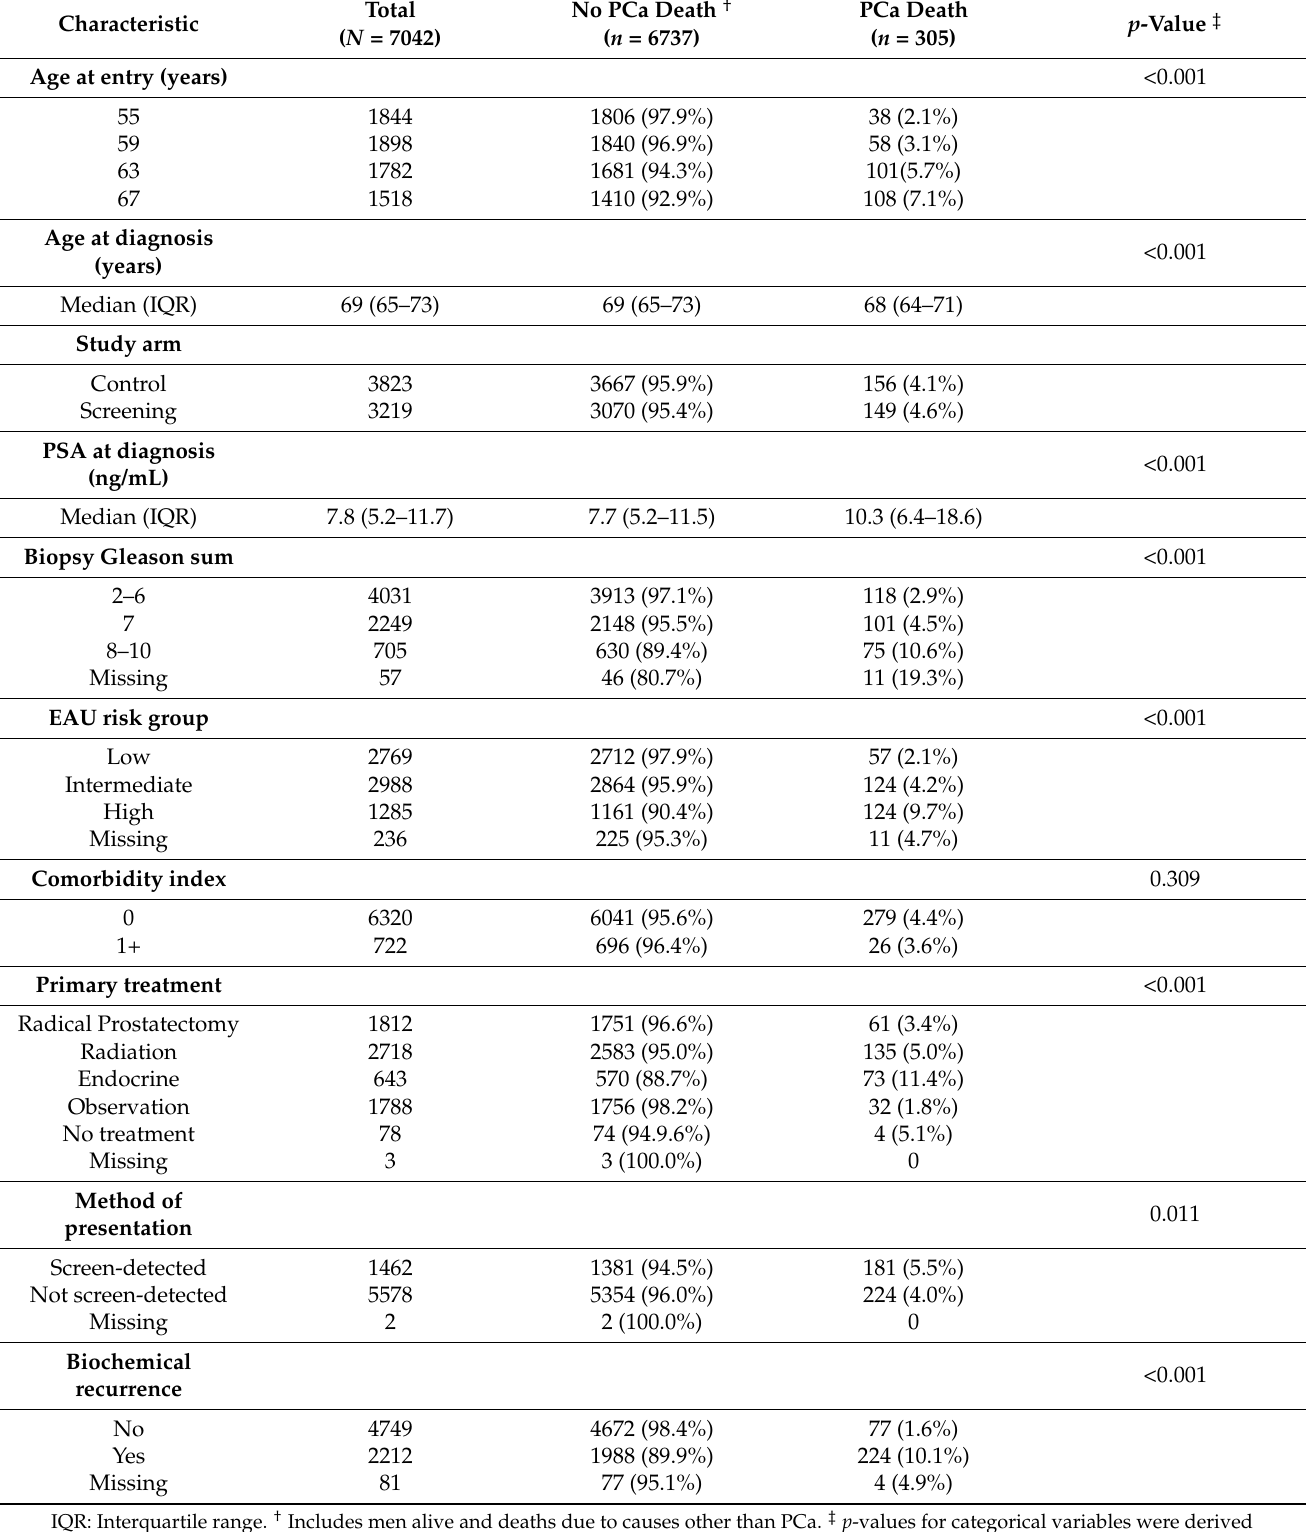
Table 1. Demographic and clinical characteristics of 7042 localized prostate cancer (PCa) patients in the cohort stratified by survival status at 20-year follow-up from the date of